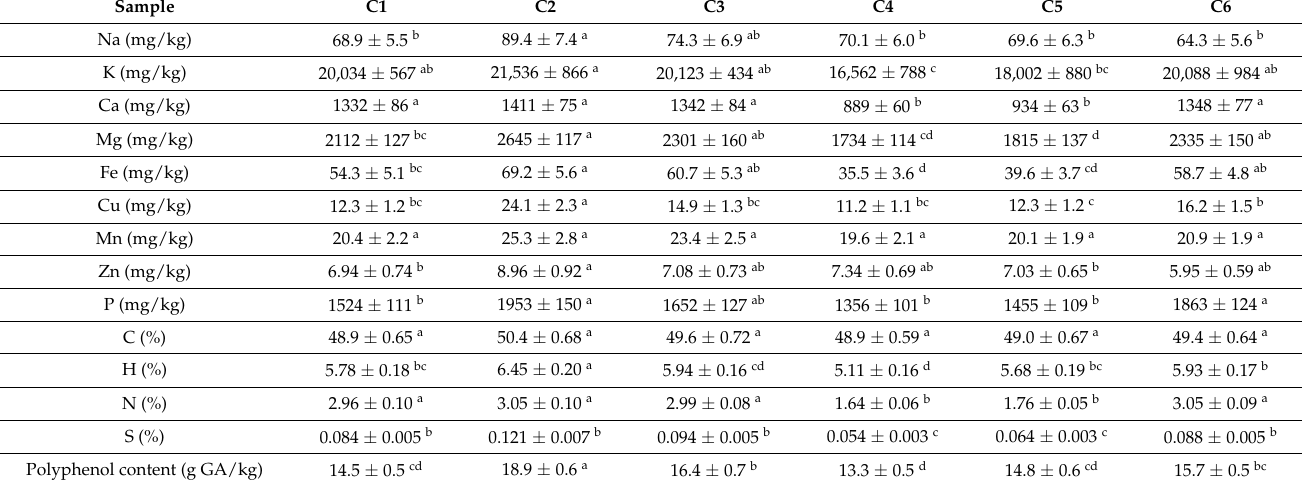
Table 2. Mineral, C, H, N, S, and polyphenol contents in the studied coffee beans expressed as averages ± standard deviations (n = 3). Different superscript letters represent significant differences ( p < 0.05) in each parameter between the coffee-bean samples.